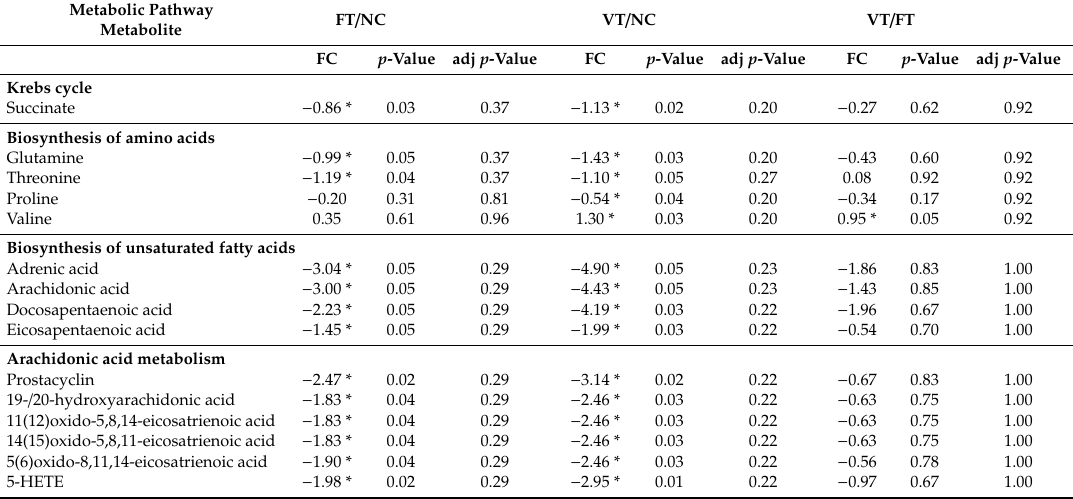
Table 2. Targeted identification of di ff erentially accumulated metabolites in day-6 embryos after in vivo development by natural conception or following fresh or vitrified embryo transfer. Asterisk denotes statistical di ff erences. FT / NC: fresh embryo transfer / naturally-conceived. VT / NC: vitrified embryo transfer / naturally-conceived. VT / FT: vitrified embryo transfer / fresh embryo transfer. FC: fold change. Metabolic Pathway